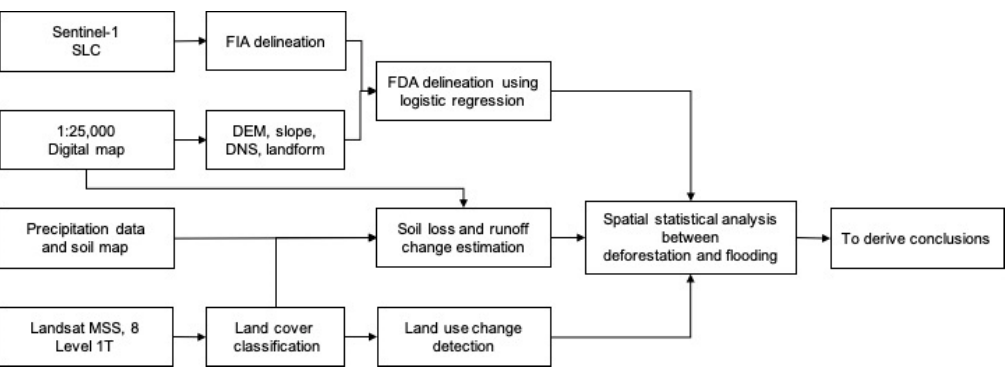
Figure 2. Flow chart showing study procedure and data processing. DEM: Digital Elevation Model, DNS: Distance from the Nearest Stream, FDA: Flood-damaged Areas, FIA: Flood Inundated Areas, MSS: Multispectral Scanner System, SLC: Single Look Complex.